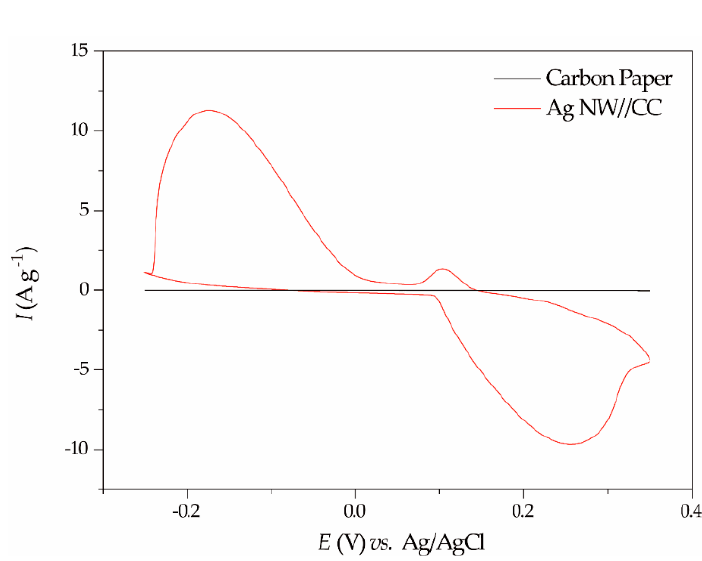
Figure 2. Cyclic voltammetry (CV) curves of pristine CC and Ag NW//CC electrodes. The current was calculated based on the normalization to the electrode weight.